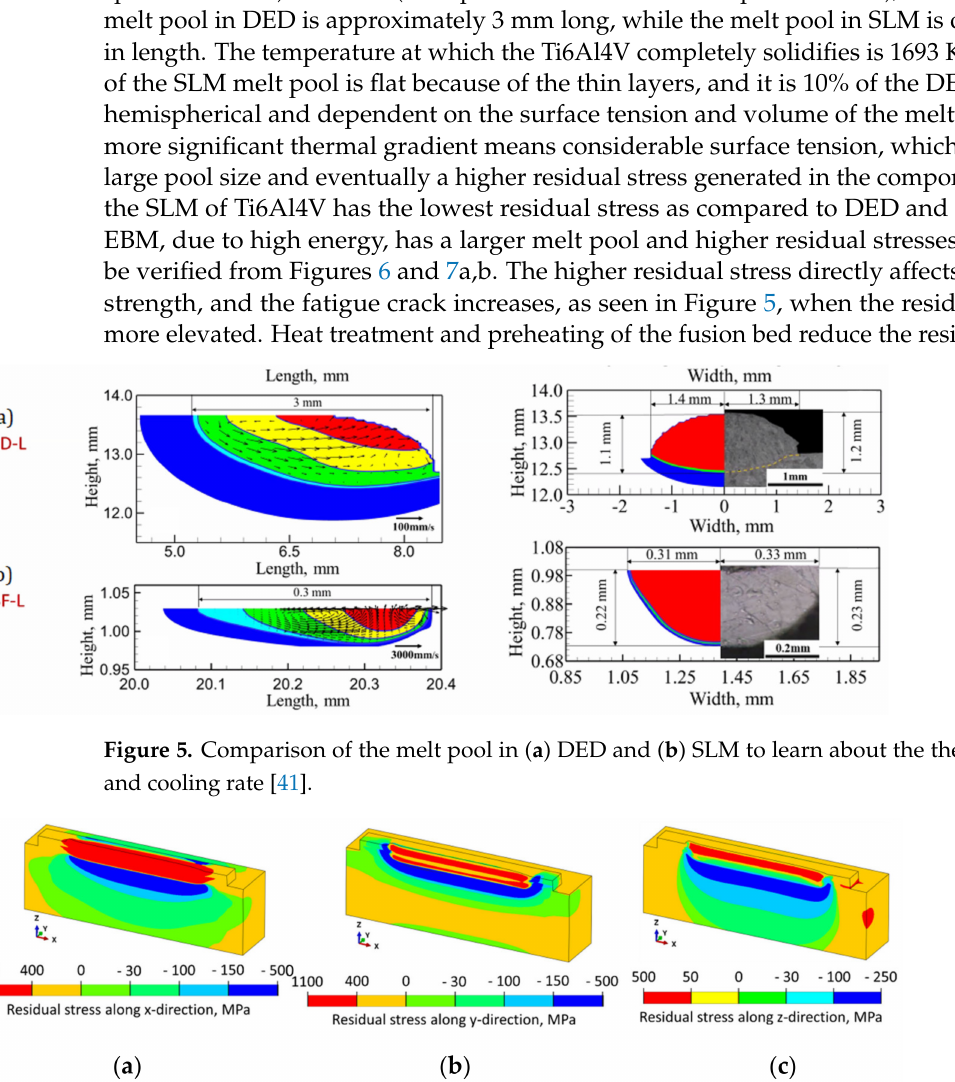
Figure 6. Residual stress distribution for Ti6Al4V along the ( a ) x, ( b ) y, and ( c ) z directions of the two-layer deposit